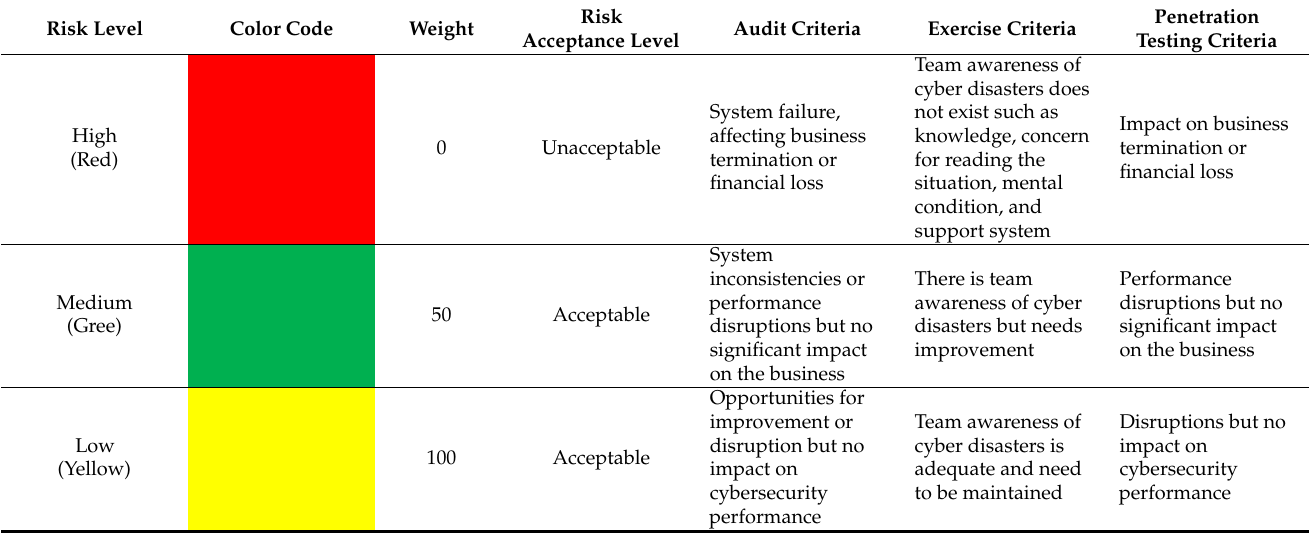
Table 4. Criteria for the Level of Risk Resulting from Audit Findings, Exercises, and Penetration Tests.